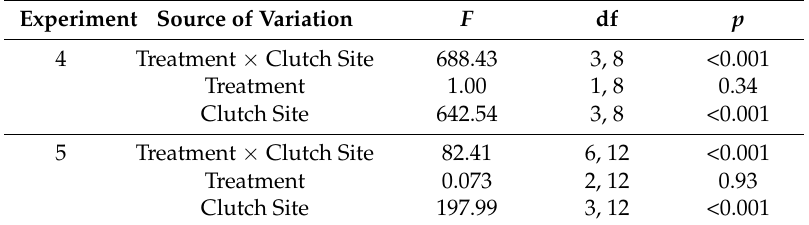
Table 3. Two-way analysis of variance (ANOVA) statistics of the interaction between treatments and clutch site selection by C . maculata females in communal 1 cages.